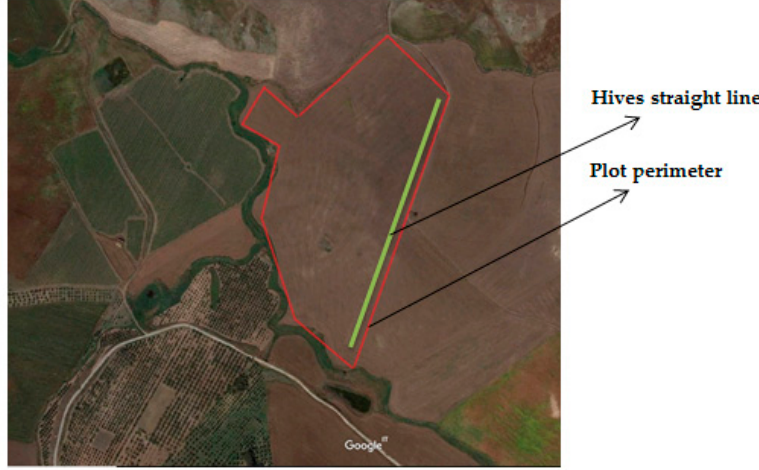
Figure 3. Experimental plot where the beehives equipped with the precision apiculture system (PAS) system were located.